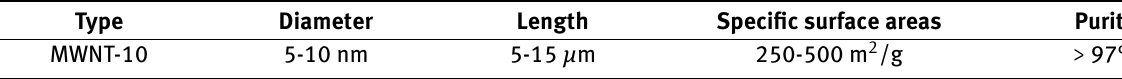
Table 1: Structure properties of MWCNTs Type